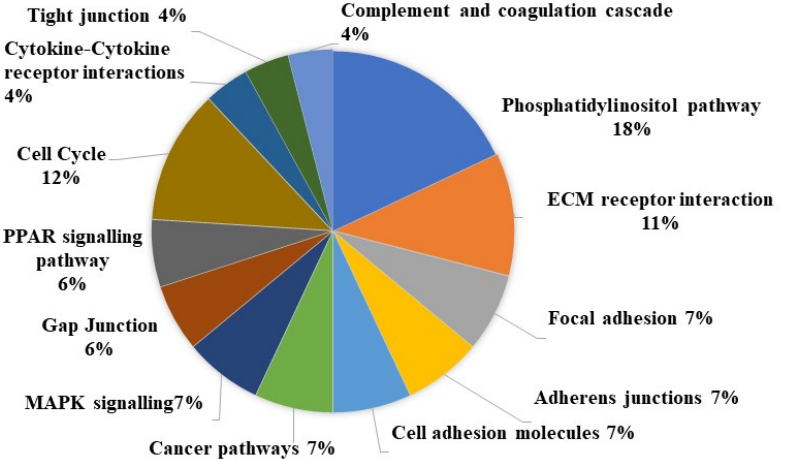
Figure 2. The most prevalent pathways affected in OSCC. This figure depicts the most prevalent pathways affected by molecular/genomic changes in OSCC. This is assessed by the number of genes in each pathway whose expression is altered. This alteration may be up- or downregulation. By grouping the affected genes by the pathways, they are involved in the most common pathways affected are the PI3K/AKT/mTOR pathway ( PIK3CA , PTEN ), the cell cycle regulation pathways ( TP53 , CDKN2A , RB1 , CREBBP ), ECM receptor interactions